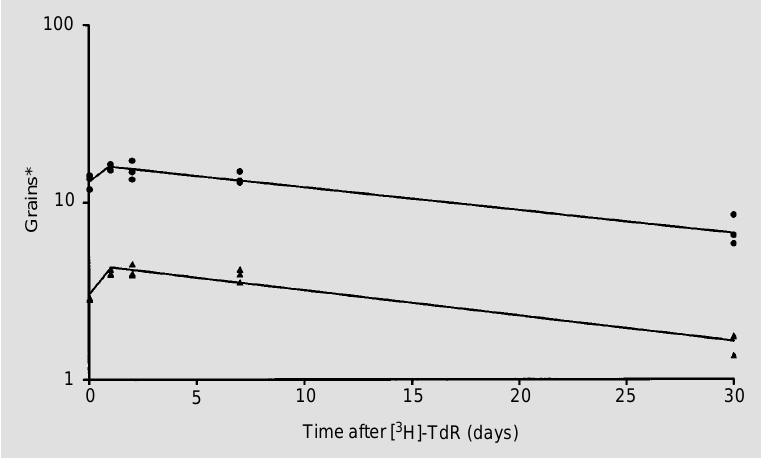
Figure 5 - Grains*, i.e., mean grain numbers per nucleus corrected and normalized (see text; circles) or corrected mean cytoplasmic grain densities (triangles) of cortical pyramidal cells, as a function of time after a single injection of [ 3 H]-TdR at t = 0 days. The lines indicate regression lines calculated for intervals with highest correlation